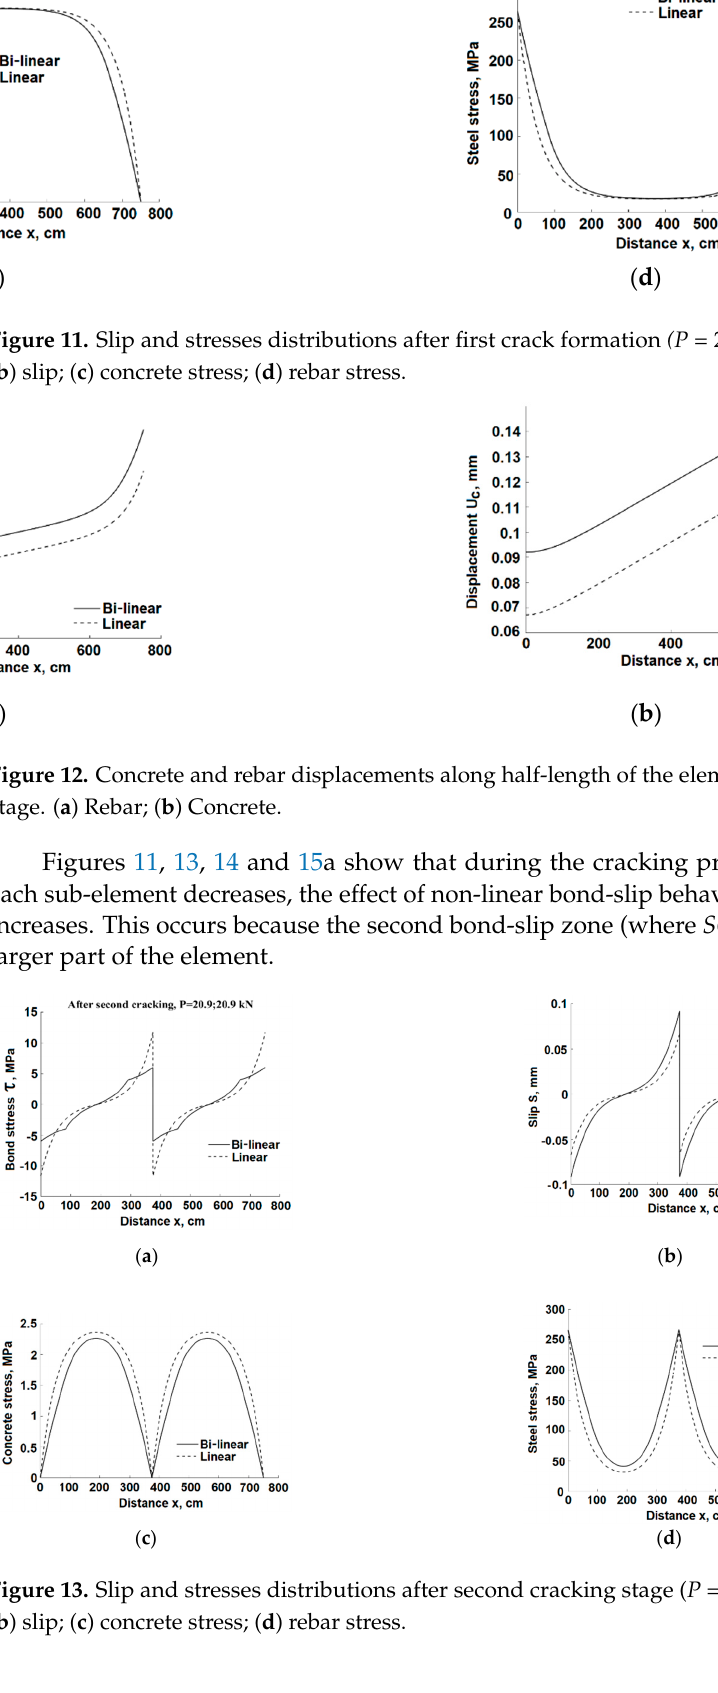
( d ) Figure 14. Slip and stresses distributions after third cracking stage ( P = 23.36 kN). ( a ) bond stress; ( b ) slip; ( c ) concrete stress; ( d ) rebar stress. ( a )